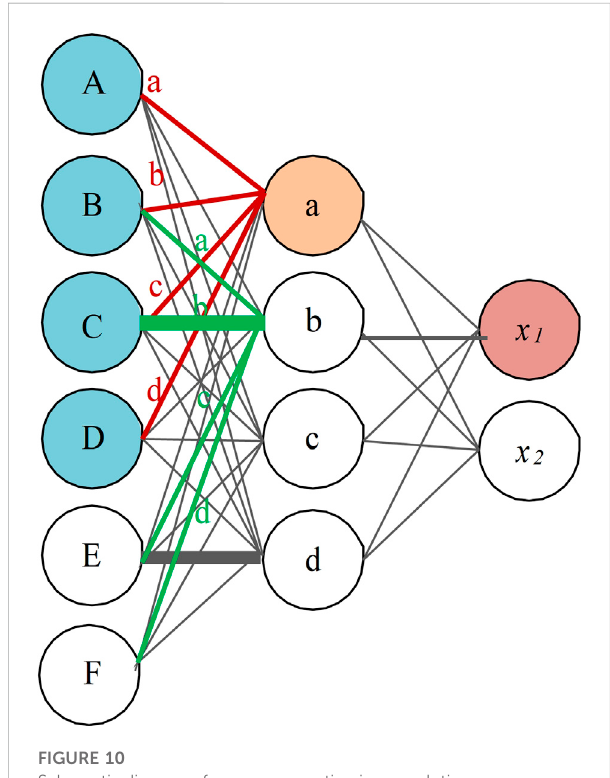
FIGURE 10 Schematicdiagramofsparseconnection